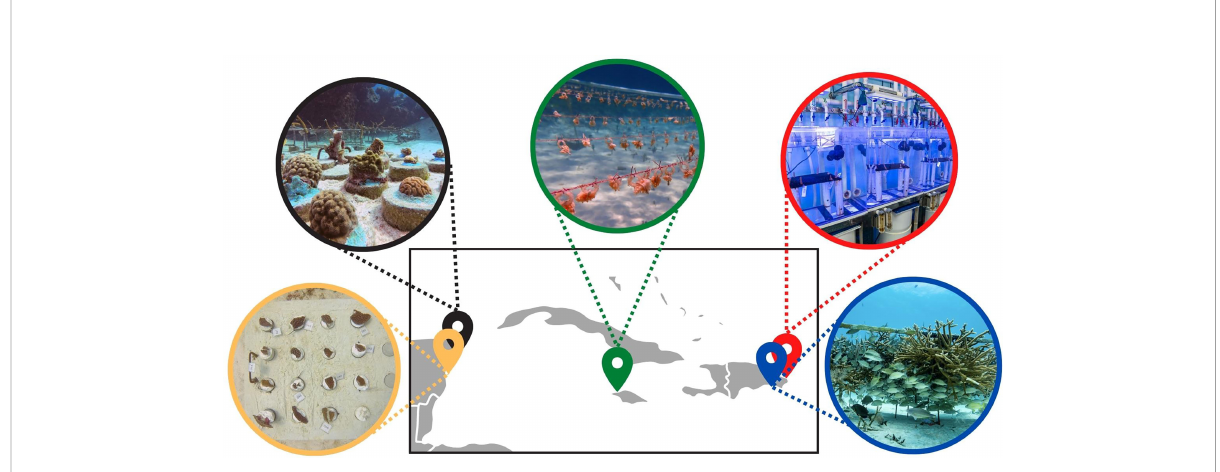
FIGURE 2 Iberostar coral nurseries ’ locations across the Caribbean: Mexico (Paraiso Beach in yellow and Cozumel in black), Jamaica (Montego Bay in green) and Dominican Republic (Bavaro Coral Lab in red and Bayahibe in